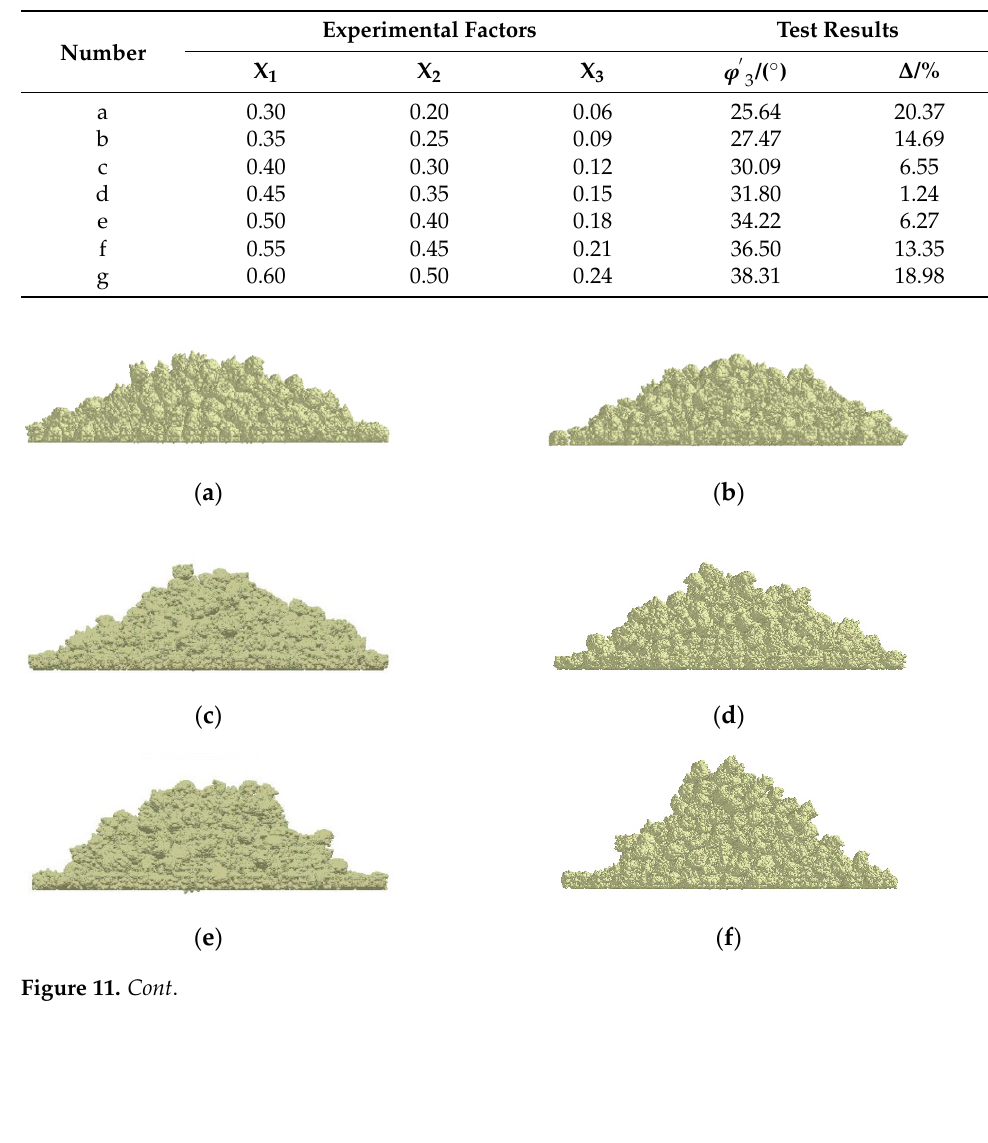
Table 6. Scheme and results of steepest ascent experiment.